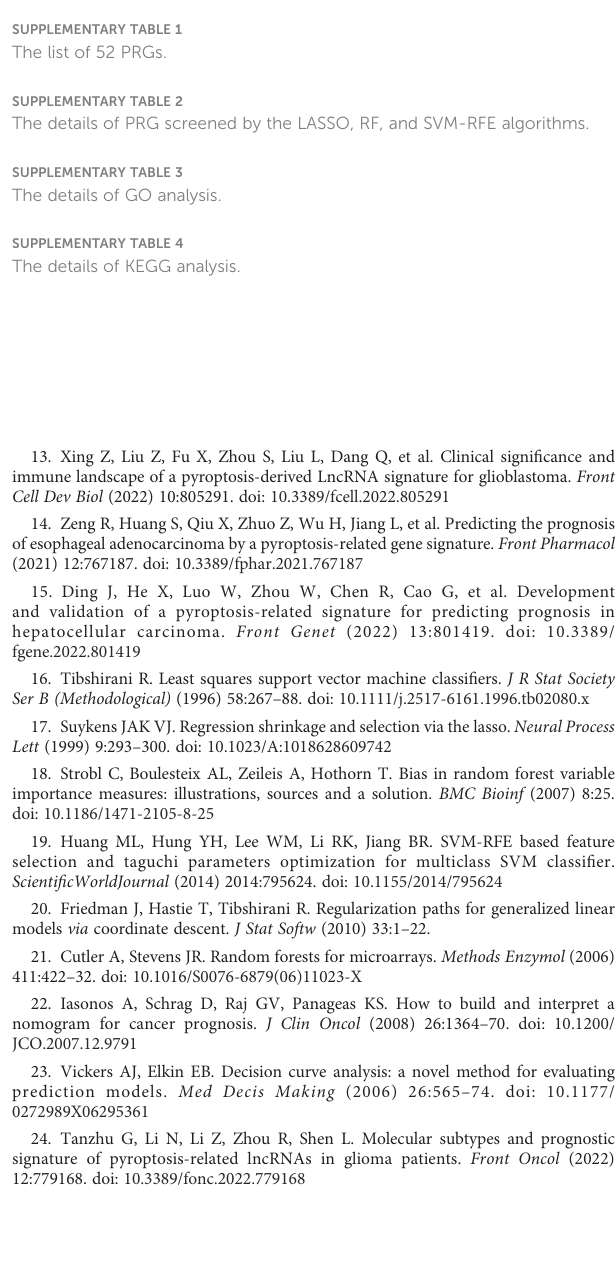
SUPPLEMENTARY TABLE 1 The list of 52 PRGs.